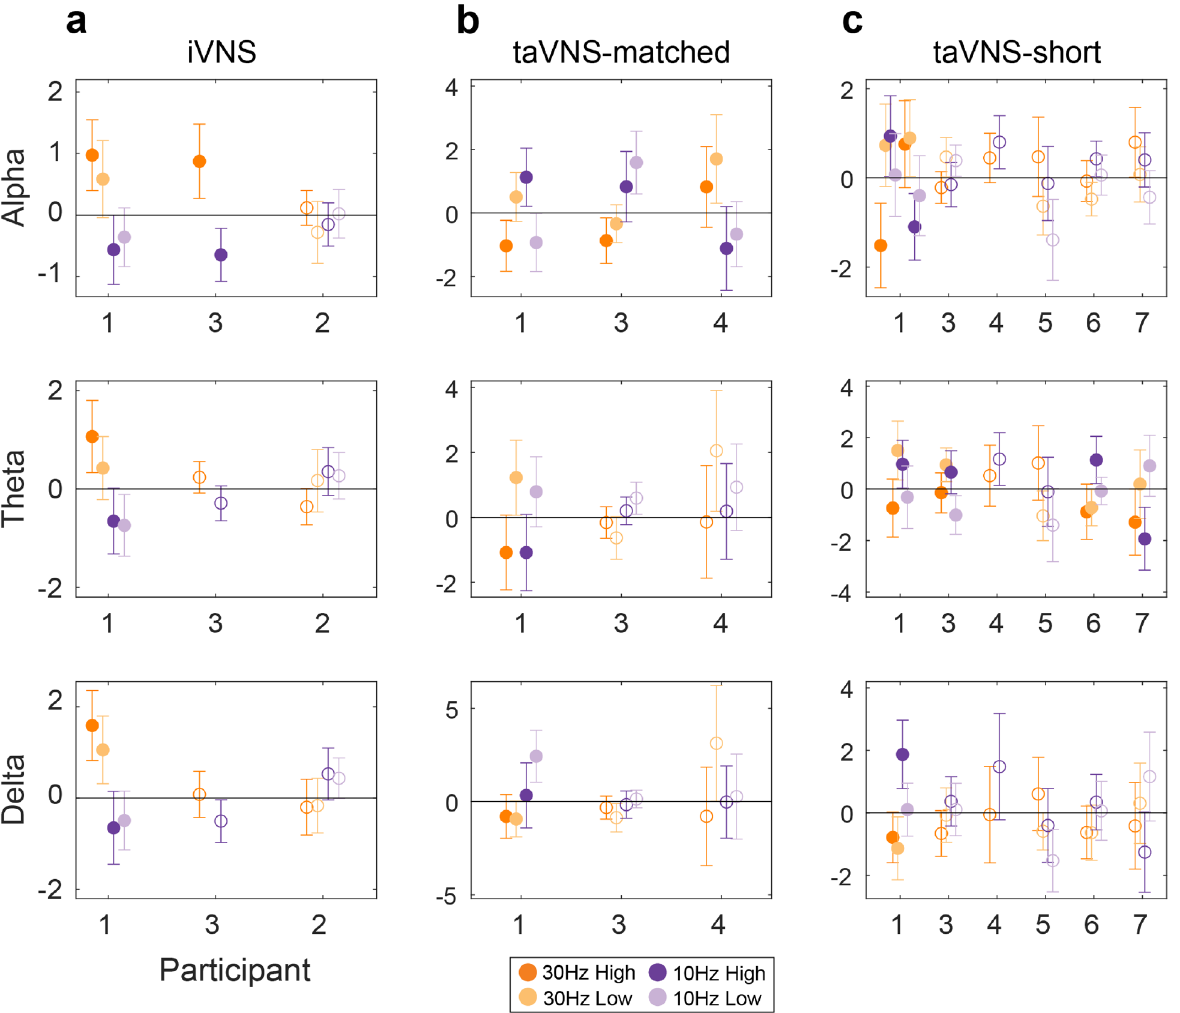
Figure 3. Patterns of VNS-evoked activity vary across spectral bands, stimulation modalities, and participants. ( a ) Aggregate results from cNMF and cluster-based permutation analyses for all participants that received iVNS. Each set of dots represents average spectral power in a spatiotemporal cluster. For clusters in which a significant effect was found (p < 0.05), filled dots denote mean and 95% confidence interval of power averaged over all time points identified by the cluster-based permutation analyses. Unfilled dots denote power averaged over a target window (iVNS/taVNS-matched: 2–9 s; taVNS-short: 0–2.5 s) for clusters in which no significant effect was found. For these, only the cluster with the largest difference in means between conditions is shown. Subject order is plotted for consistency across modalities. ( b ) Aggregate results for taVNS-matched. ( c ) Aggregate results for